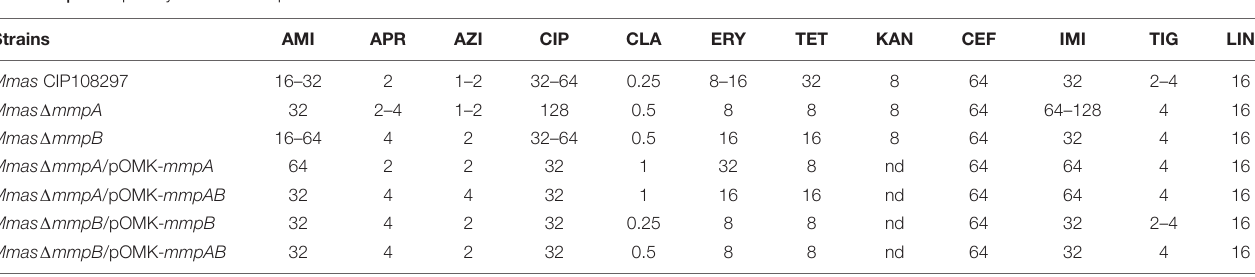
TABLE 1 | Susceptibility of the Mmas porin mutants to